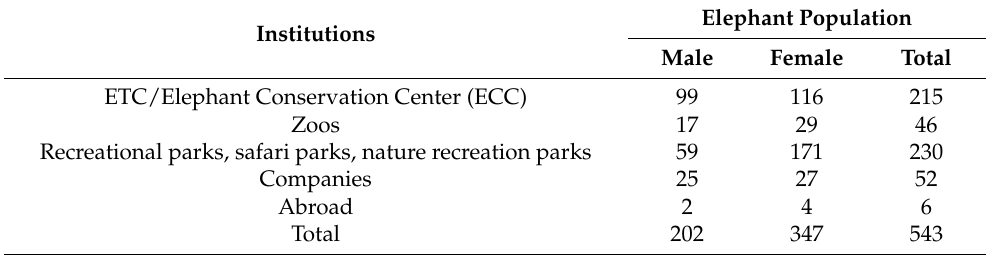
Table 2. Distribution of captive elephants in different